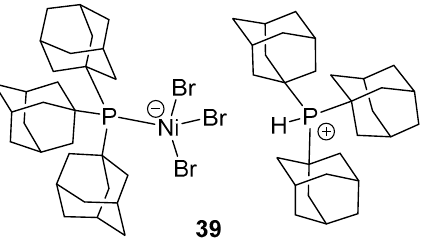
Figure 33. Monodentate phosphine tri -1-adamantylphosphine-nickel catalyst 39 .